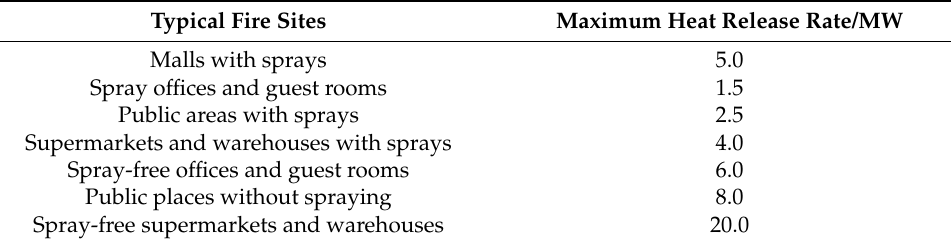
Table 2. Maximum heat release rate of typical fire sites.